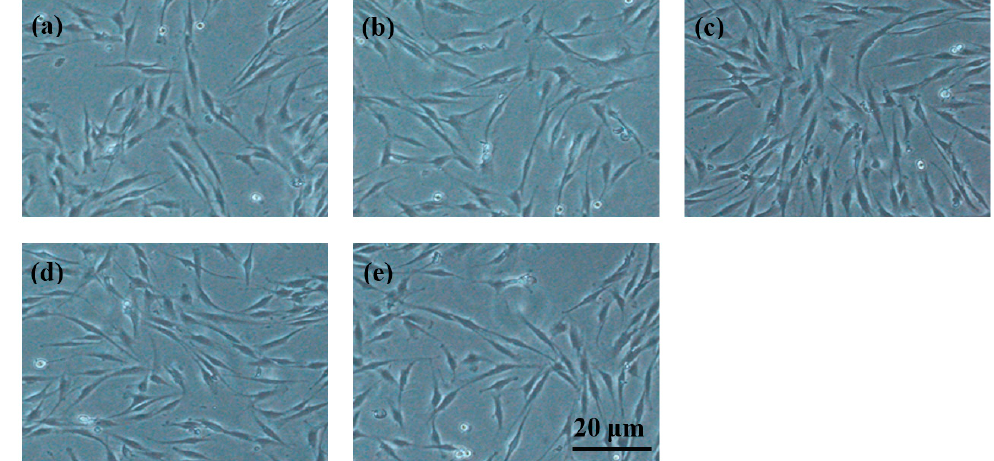
Figure 12. Optical microscopy of BMSCs after three days of incubation: ( a ) negative control; ( b ) MZM extracts; ( c ) MZM-0.38 Ca extracts; ( d ) MZM-0.76 Ca extracts; and ( e ) MZM-1.10 Ca extracts. All the scale bar represents 20 μ m.